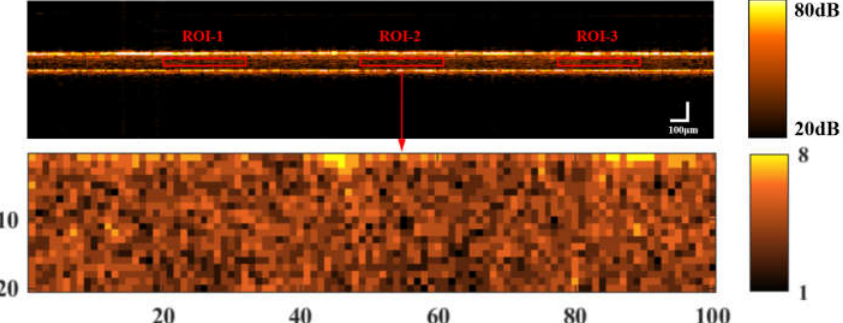
Figure 3. Excluding the cuticle and basement membrane, the 0.05 mm (z) × 1 mm (x) ROI (20 pixel (z) × 100 pixel (x)) was selected within the skin for texture characterization.